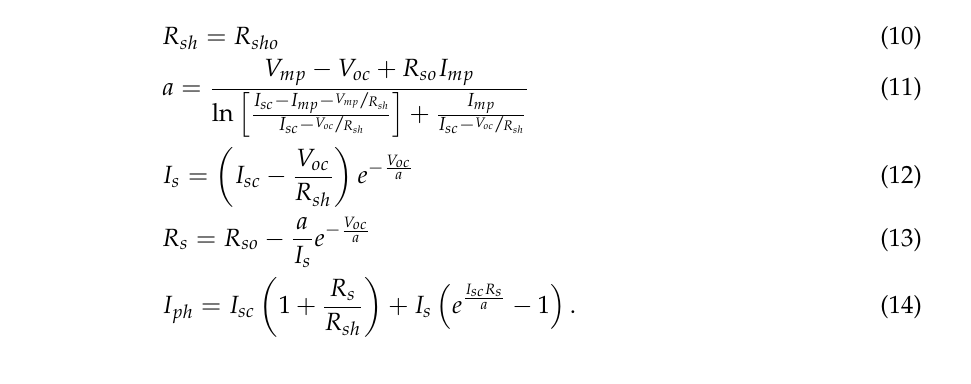
Table 1. Main attributes of the 17 non-iterative parameter extraction